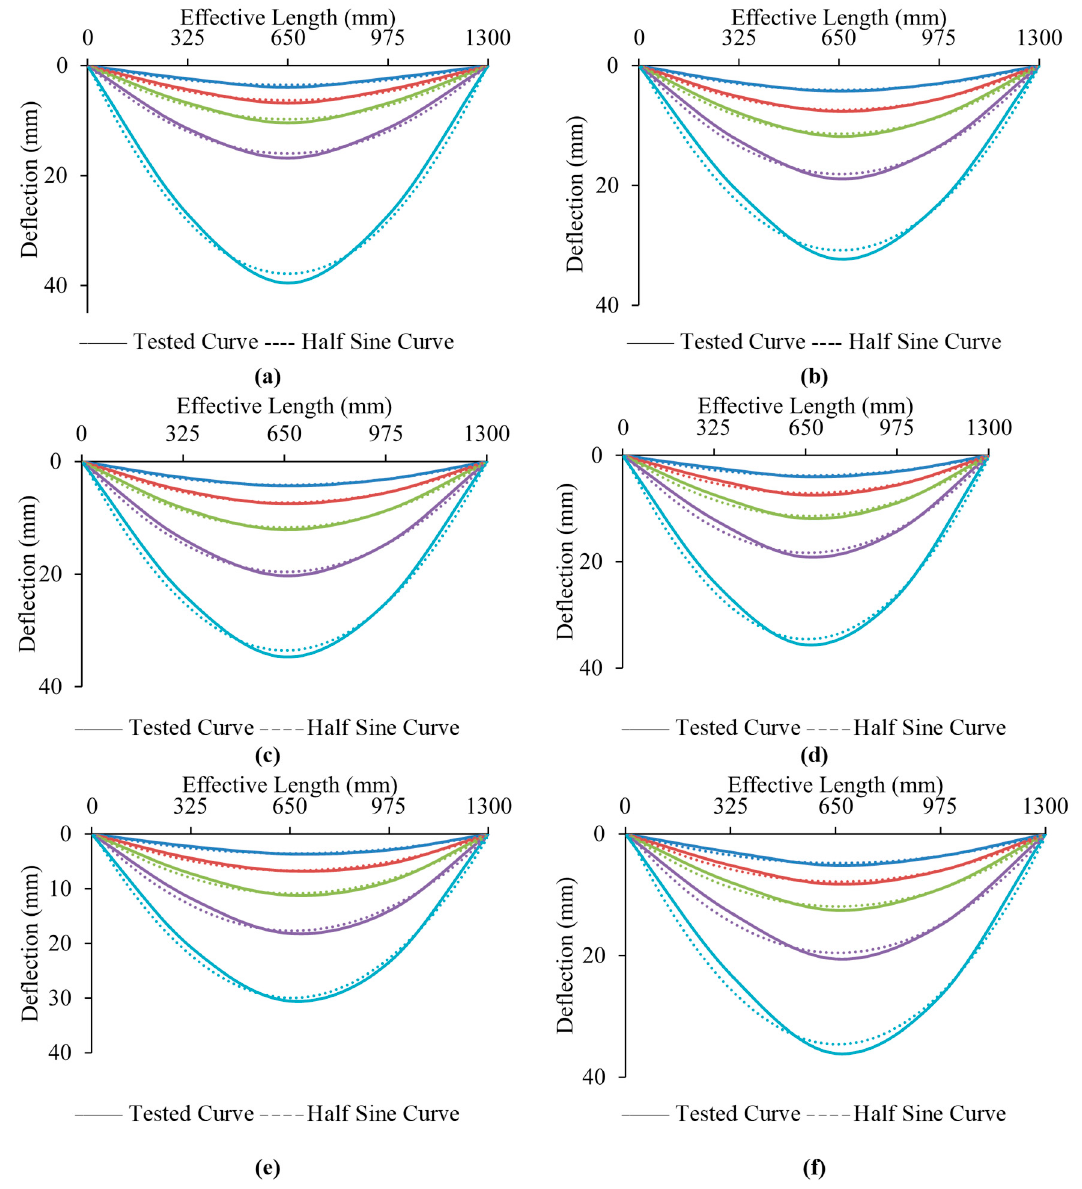
Figure 16. Deformation shapes in various loading phases: ( a ) B-C; ( b ) B-P100-3L; ( c ) B-P100-2L; ( d ) B-